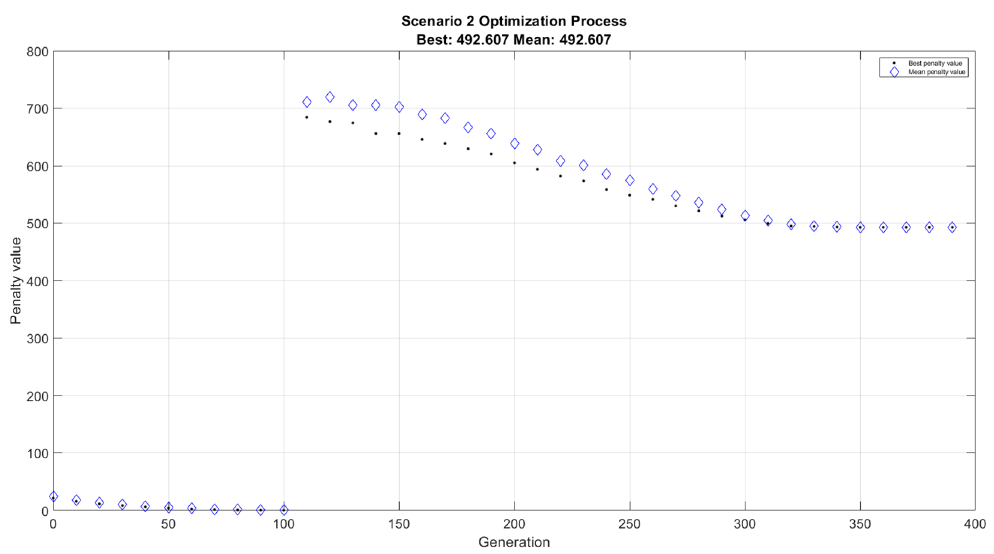
Figure 2. Scenario 1 optimization process.